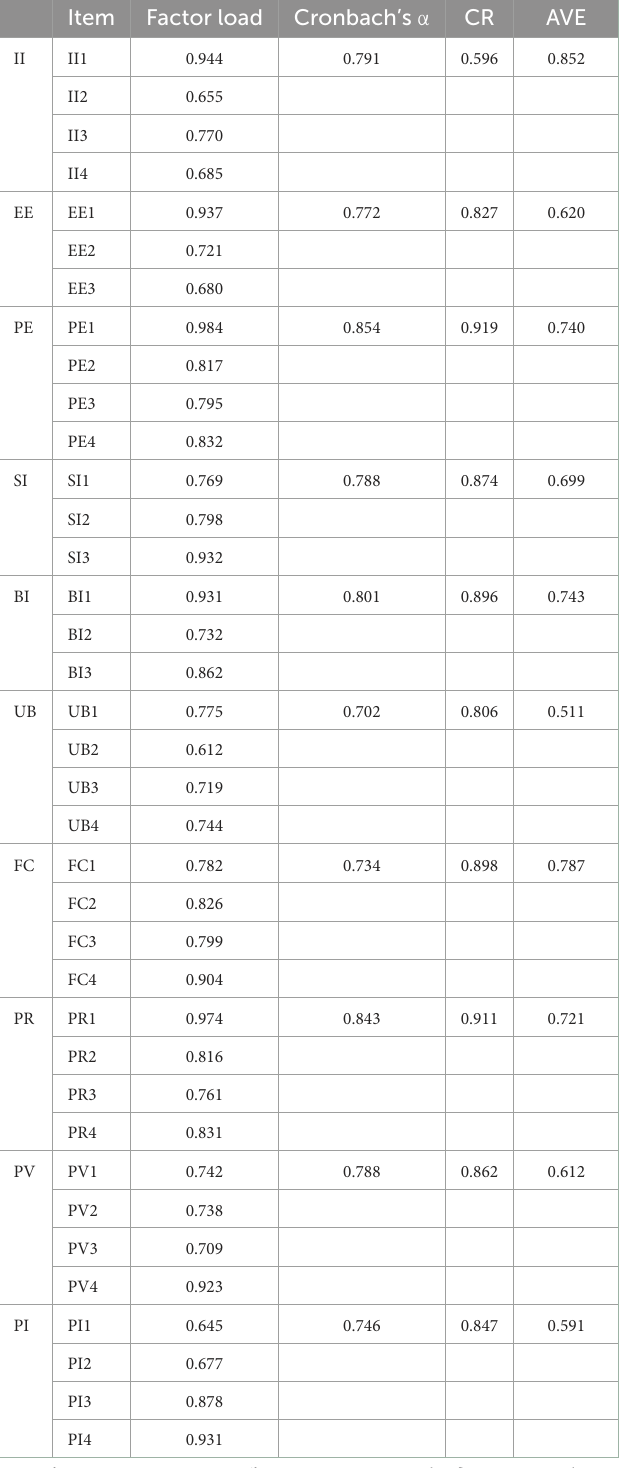
TABLE 2 Reliability and validity analysis of the measurement model in this